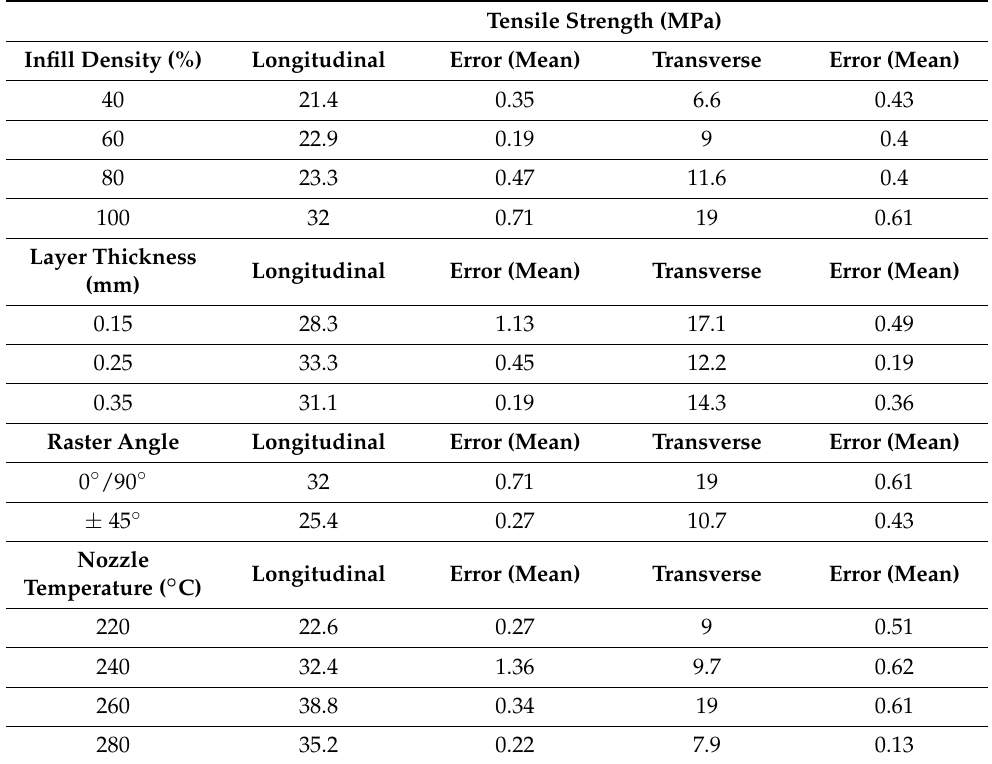
Table 1. Effects of infill density, layer thickness, raster angle and nozzle temperature on tensile strength. Tensile Strength (MPa) Infill Density (%) Longitudinal Error (Mean) Transverse Error